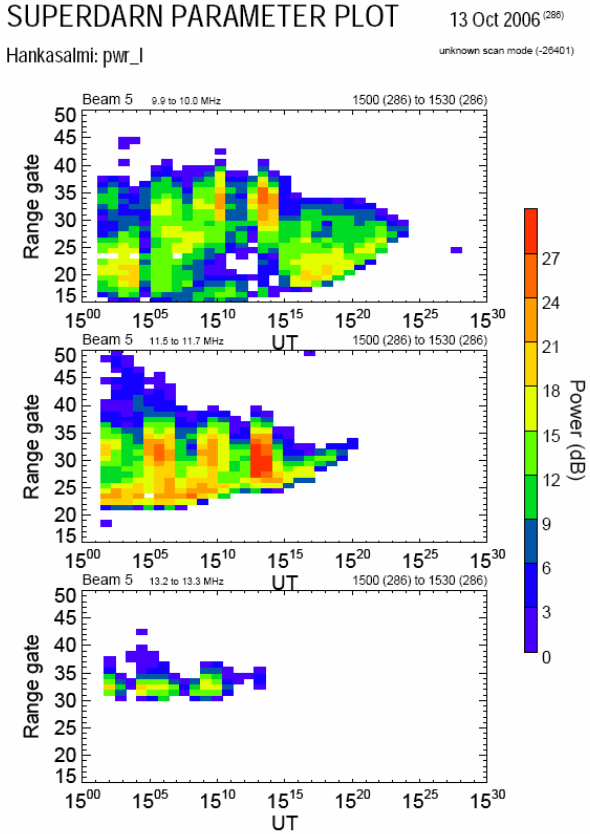
Fig. 5 Fig. 5. Backscattered power from the Hankasalmi (Finland) CUT- LASS radar at operational frequencies of about 10, 11.5 and 13.3MHz on 13 October 2006 between 15:01 and 15:30UT. The CUTLASS Hankasalmi radar was running a non-standard scan for heating. It had 15km range gates, with the first gate starting at a range of 480km. The EISCAT/HEATING facility transmitted from 15:00–15:02, 15:04–15:06, 15:08–15:10, and